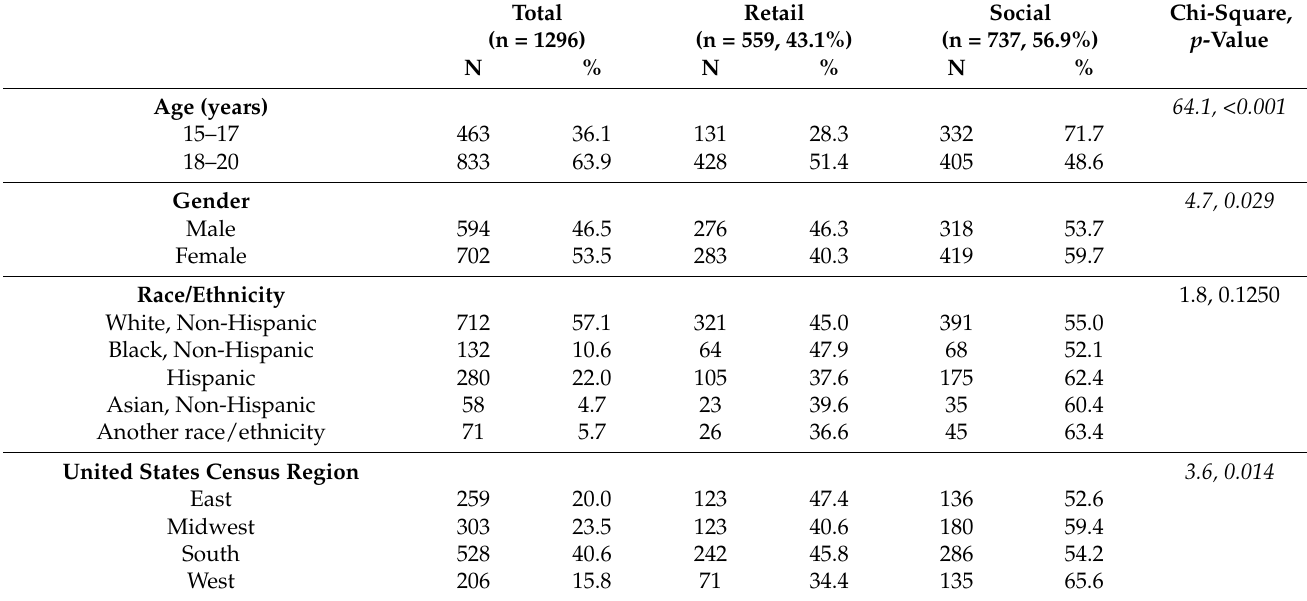
Table 1. Sociodemographic, residential, and device type characteristics by source of acquisition among current e-cigarette users (5 January 2022–30 August